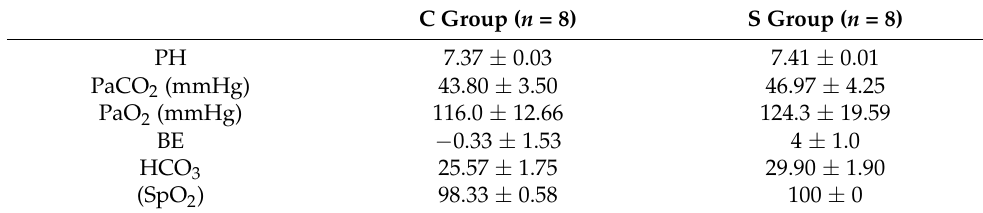
Table 1. Arterial blood gas analysis of the two